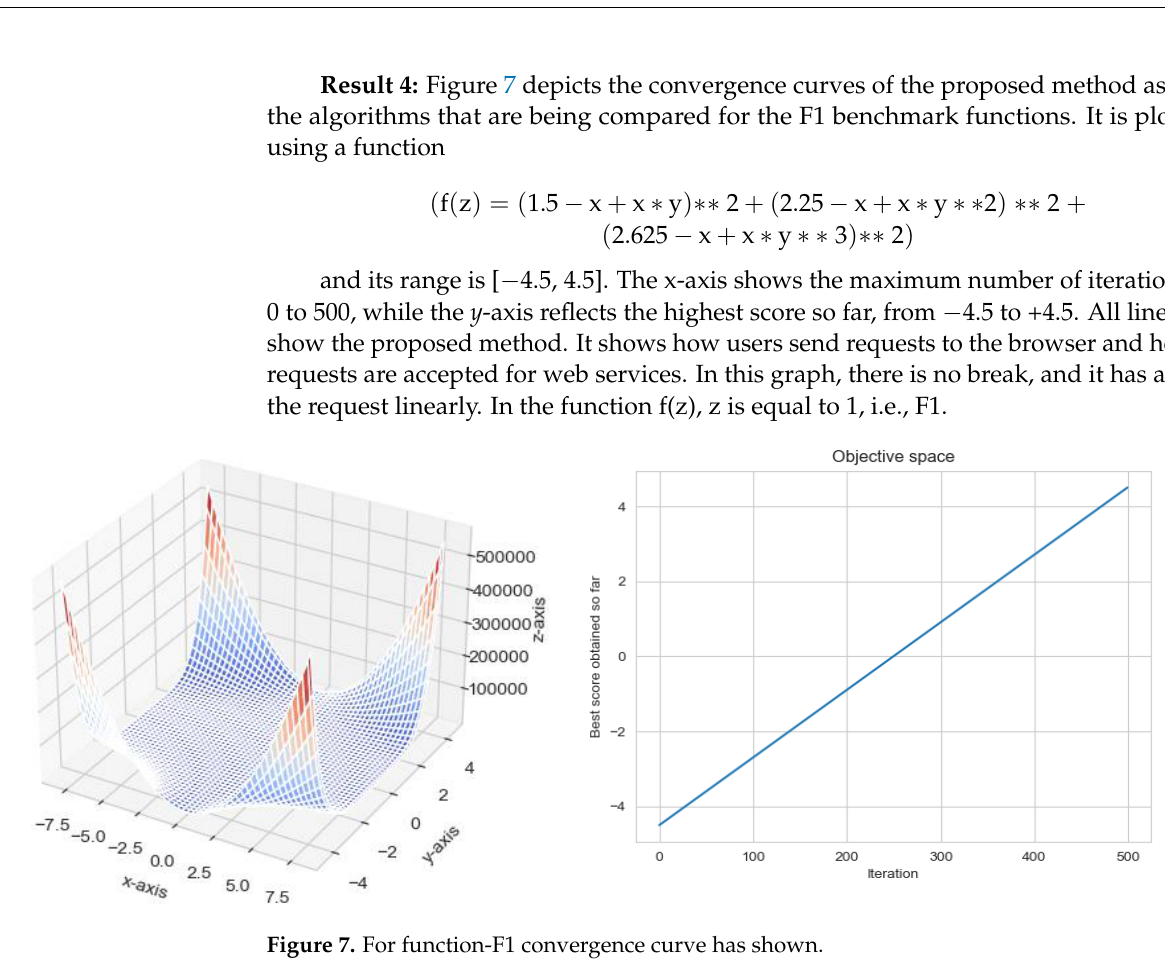
Figure 8. For function-F2 convergence curve has shown.